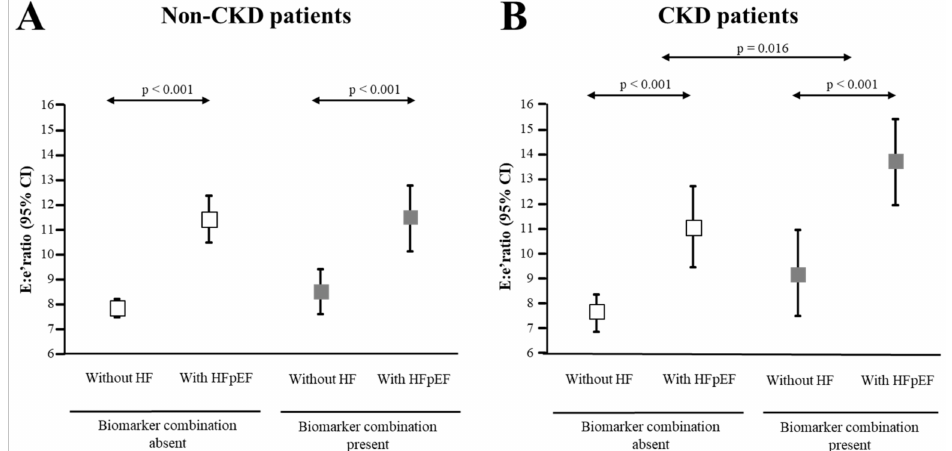
Figure 2. Distribution of the maximal early transmittal flow velocity in diastole (E) to the early mitral annulus velocity in diastole (septal and lateral average) (e’) (E:e’) ratio values. ( A ) Panel A shows values in the group of patients without chronic kidney disease (non-CKD patients); ( B ) Panel B shows values in the group of patients with CKD (CKD patients). Patients were further classified according to the presence or absence of the combination of biomarkers of malignant myocardial fibrosis as defined in the text and then to the absence of heart failure (without HF) or the presence of HF with preserved ejection fraction (with HFpEF). Symbols represent means and 95% confidence intervals adjusted for age and